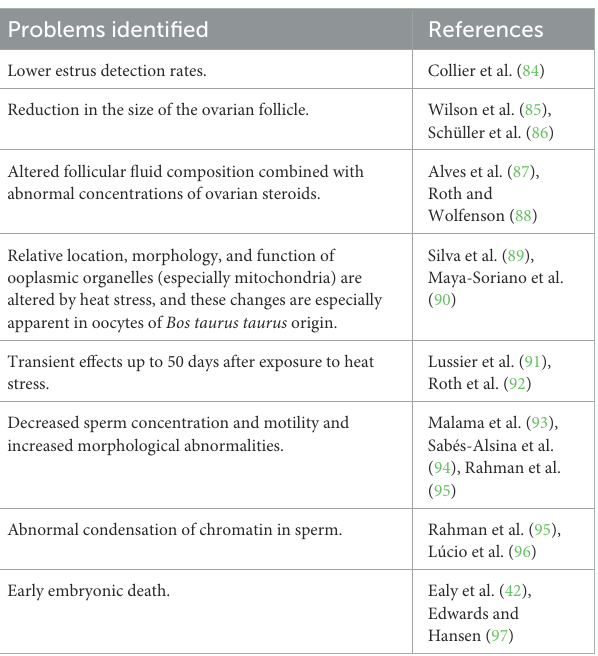
TABLE 4 Reproductive problems identified in dairy cows under heat